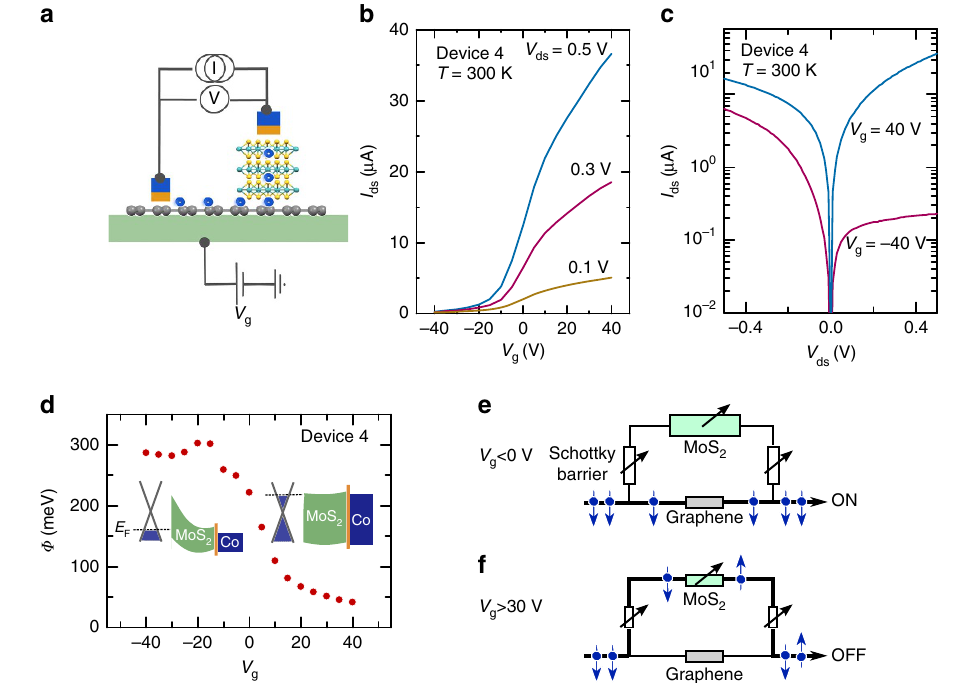
Figure 4 | Tuning the Schottky barrier at the MoS 2 /graphene interface by gate voltage. ( a ) Schematics of the graphene/MoS 2 vertical heterostructure. ( b ) Transfer characteristic (drain–source current I ds versus gate voltage V g for different drain–source voltages V ds ) in a vertical device with MoS 2 thickness of 35nm. ( c ) Output characteristics ( I ds versus V ds ) at V g ¼ (cid:4) 40V. ( d ) Schottky barrier height ^ obtained for different V g . Inset: Band structures at the MoS 2 /graphene interface for V g o 0Vand V g 4 30V. ( e ) Representative circuit diagram of the graphene and MoS 2 parallel transport channels connected by Schottky barrier resistors in the heterostructure. At gate voltages V g o 0V, the large Schottky barrier and high MoS 2 resistance prevents spins from interacting with the high SOC MoS 2 channel, resulting in a finite spin transport in graphene and corresponds to the spin-ON state. ( f ) At high gate voltages V g 4 30V, the reduced Schottky barrier and MoS 2 channel resistance allows spins to tunnel into MoS 2 and hence dephasing in the high-SOC material, resulting in the spin-OFF